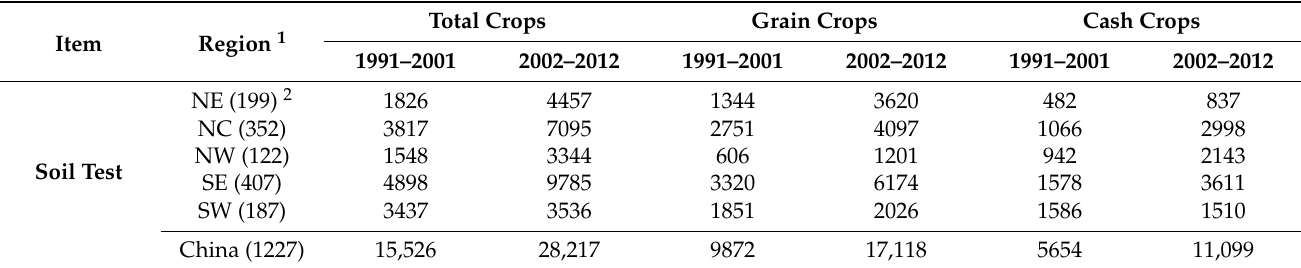
Figure 1. Distribution of experimental sites across five geographical regions in China’s croplands from 1991 to 2012. The green and blue dots represent grain and cash crops, respectively. Table 1. Numbers of experimental observation across five geographical regions and two periods of the 1991–2001 and the 2002–2012 in China’s croplands.